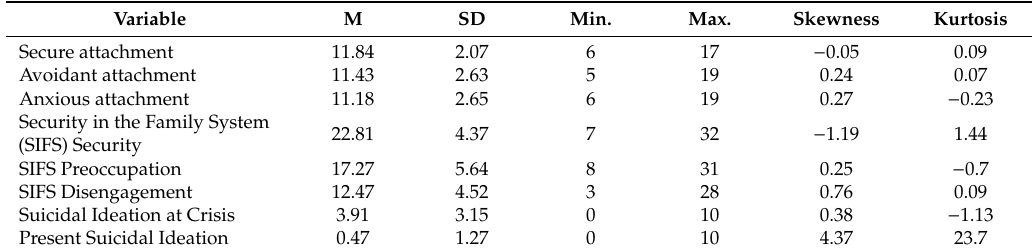
Table 2. Descriptive statistics of attachment style, emotional security in the family system, and suicidal ideation among CSA survivors ( n = 188).